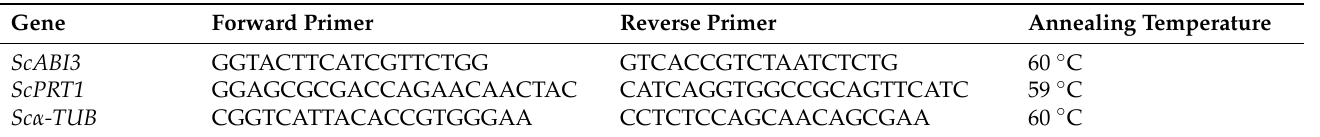
Table 1. Primer information for